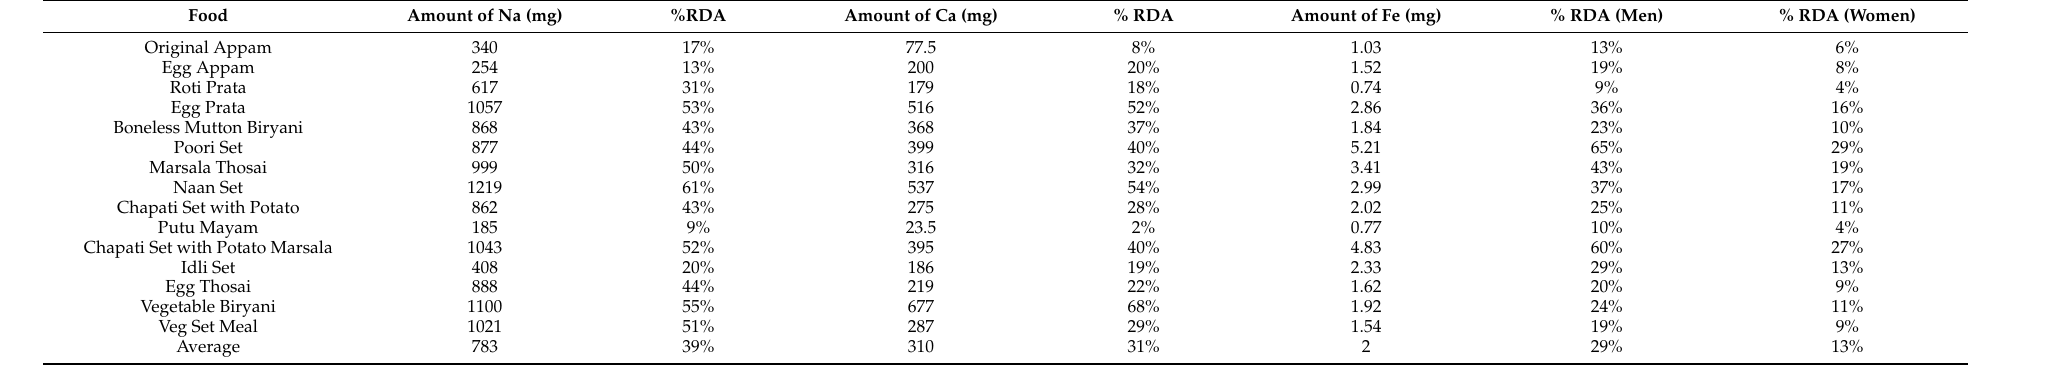
Table 9. Mineral content and the %RDA of the commonly consumed Indian